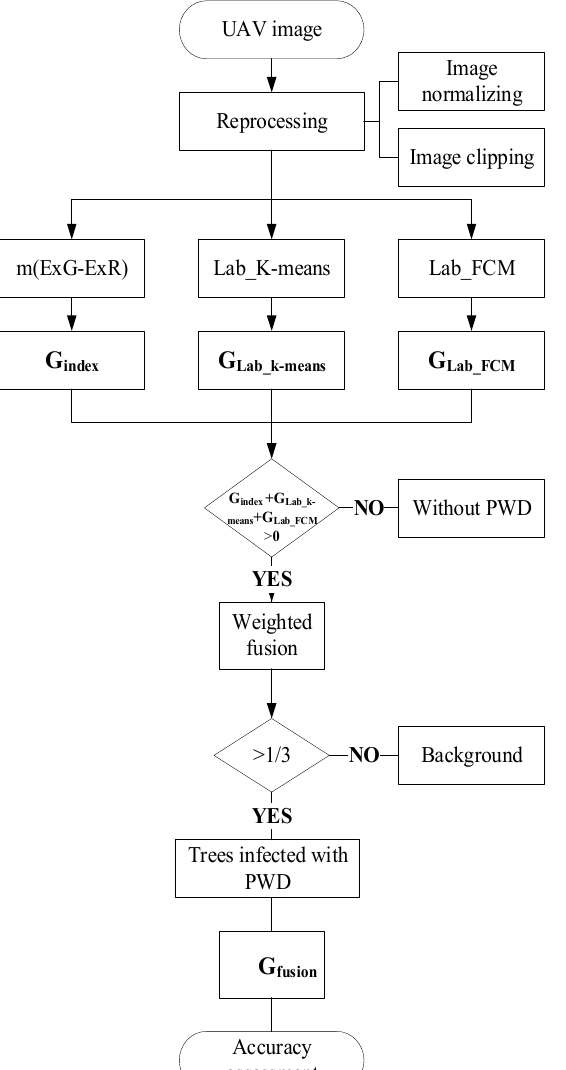
Figure 5. The flow of unsupervised learning with decision fusion.